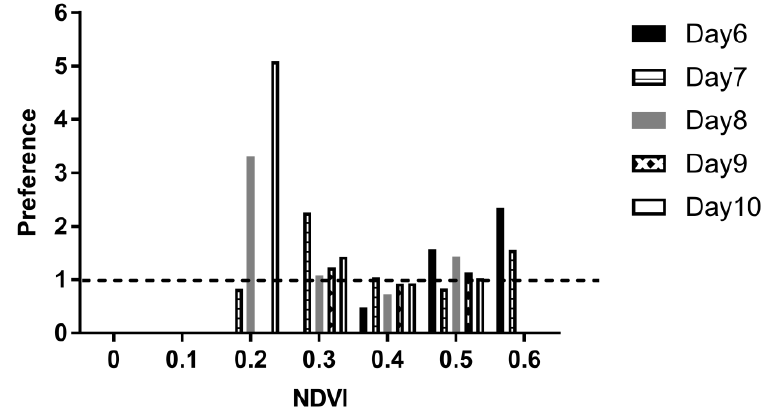
Figure 6. Preference index for grazing hours (where grazing occurred ≥ 50% of time during behaviour observations) during the GNSS collar period (Days 6–10). A preference value of ≥ 1 (above the dashed line) indicates cattle were actively selecting areas with the associated NDVI values, whereas ≤ 1 highlights avoidance by cattle.